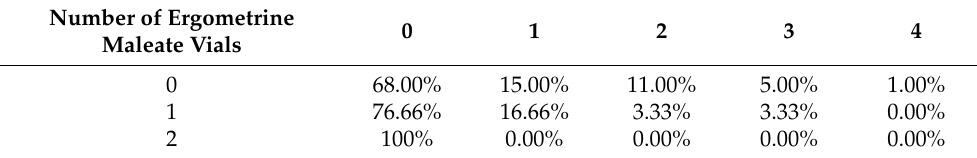
Table 15. The PUUS values of patients regarding the number of ergometrine maleate vials received. Number of